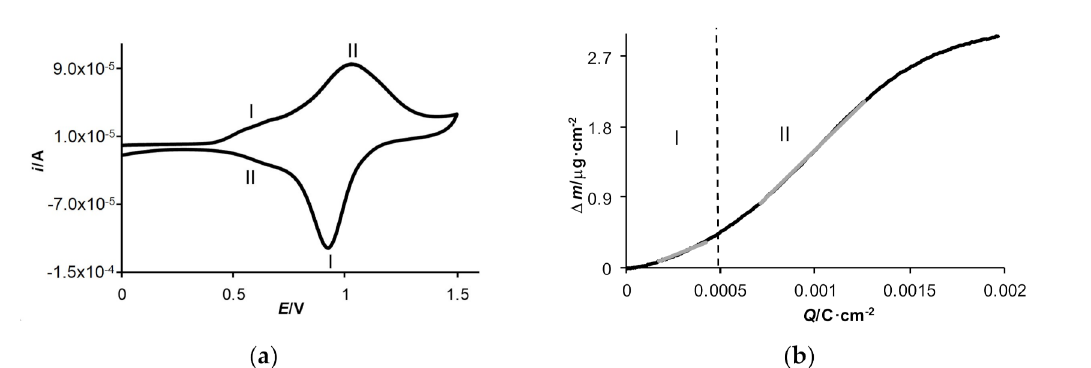
Figure 7. Poly [Ni(salcn)] (1 electropolymerization cycle) in TBAClO 4 /MeCN, Pt/quarzglas, v = 0.05 V · s − 1 , vs. Ag/AgCl; ( a ) cyclic voltammogram; ( b ) plot ∆ m vs. Q for anodic process; grey parts of the curve—trend lines for the ∆ m = f( Q ) relationship. I and II—peaks labels.